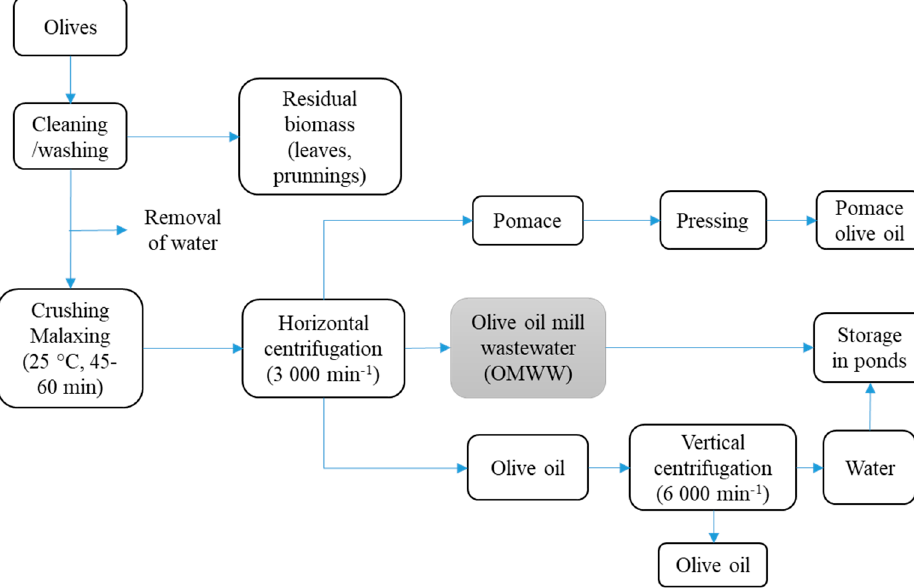
Figure 1. Overview of the main steps taking place in an olive oil mill, adopting the continuous (centrifugation) process. The production of olive oil mill wastewater (OMWW), presently left untreated and thereby with high environmental pollution potential, is highlighted.